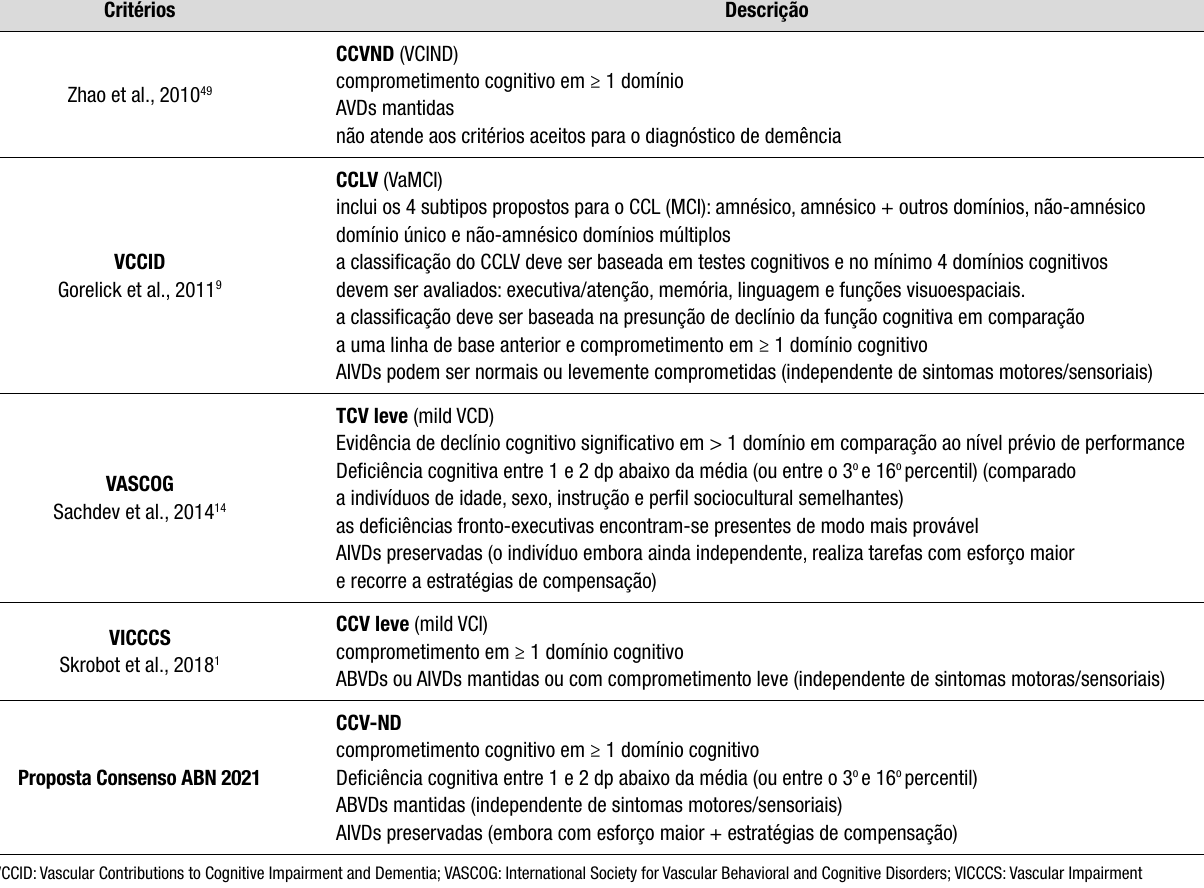
Tabela 1. Critérios diagnósticos do comprometimento cognitivo vascular – não demência